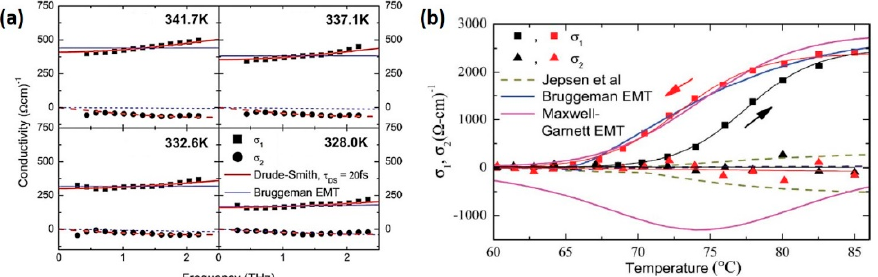
Figure 3. Predictions of Drude-Smith model and effective medium theory (EMT) model. ( a ) Complex conductivity of VO 2 thin film on a-sapphire substrate at different temperatures as the sample is cooled. Fits are for the Drude-Smith model (thick red lines) and Bruggeman EMT (thin blue lines). Reproduced from [77], with permission from American Institute of Physics 2010. ( b ) Complex conductivity of the VO 2 thin film grown on c-sapphire as a function of temperature during heating (black symbols) and cooling (red symbols). The blue and magenta curves show the predictions of the Bruggeman EMT and MG EMT, respectively. Reproduced from [73], with permission from Optical Society of America